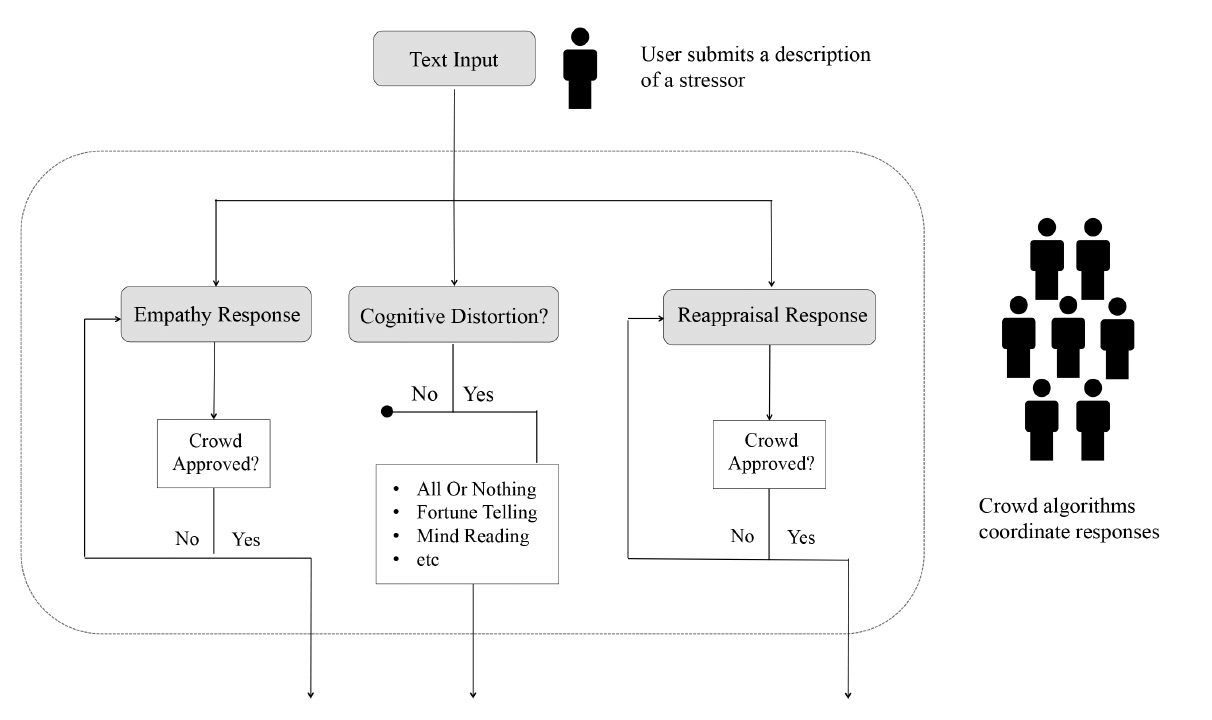
Figure 3. Multiple sets of crowd workers are coordinated to compose and curate responses on the system. The cognitive distortions are identified and labeled, but not subject to crowd